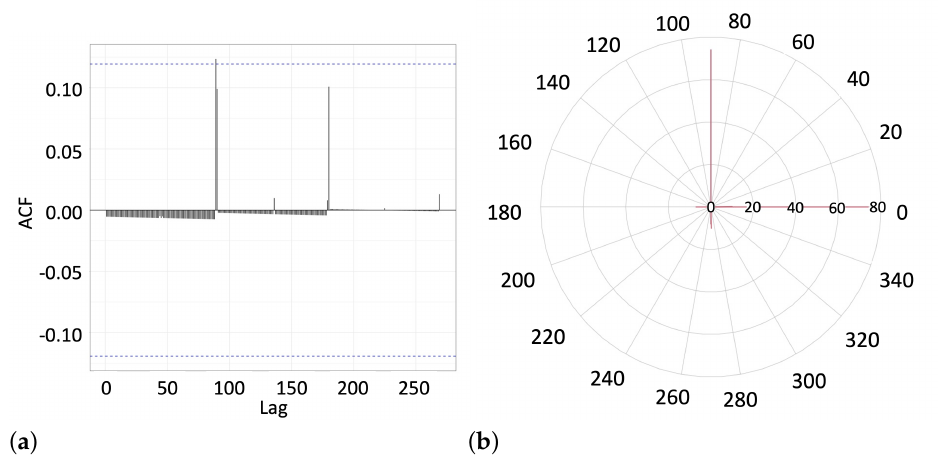
Figure 8. ( a ) The autocorrelation function (10) represents the statistical significance of lags between the sequential line angles in Group 4. The dashed horizontal line marks the level of statistically significant correlations. ( b ) The radial histogram (not normalized) of the line-drawing angles observed in Group 4.